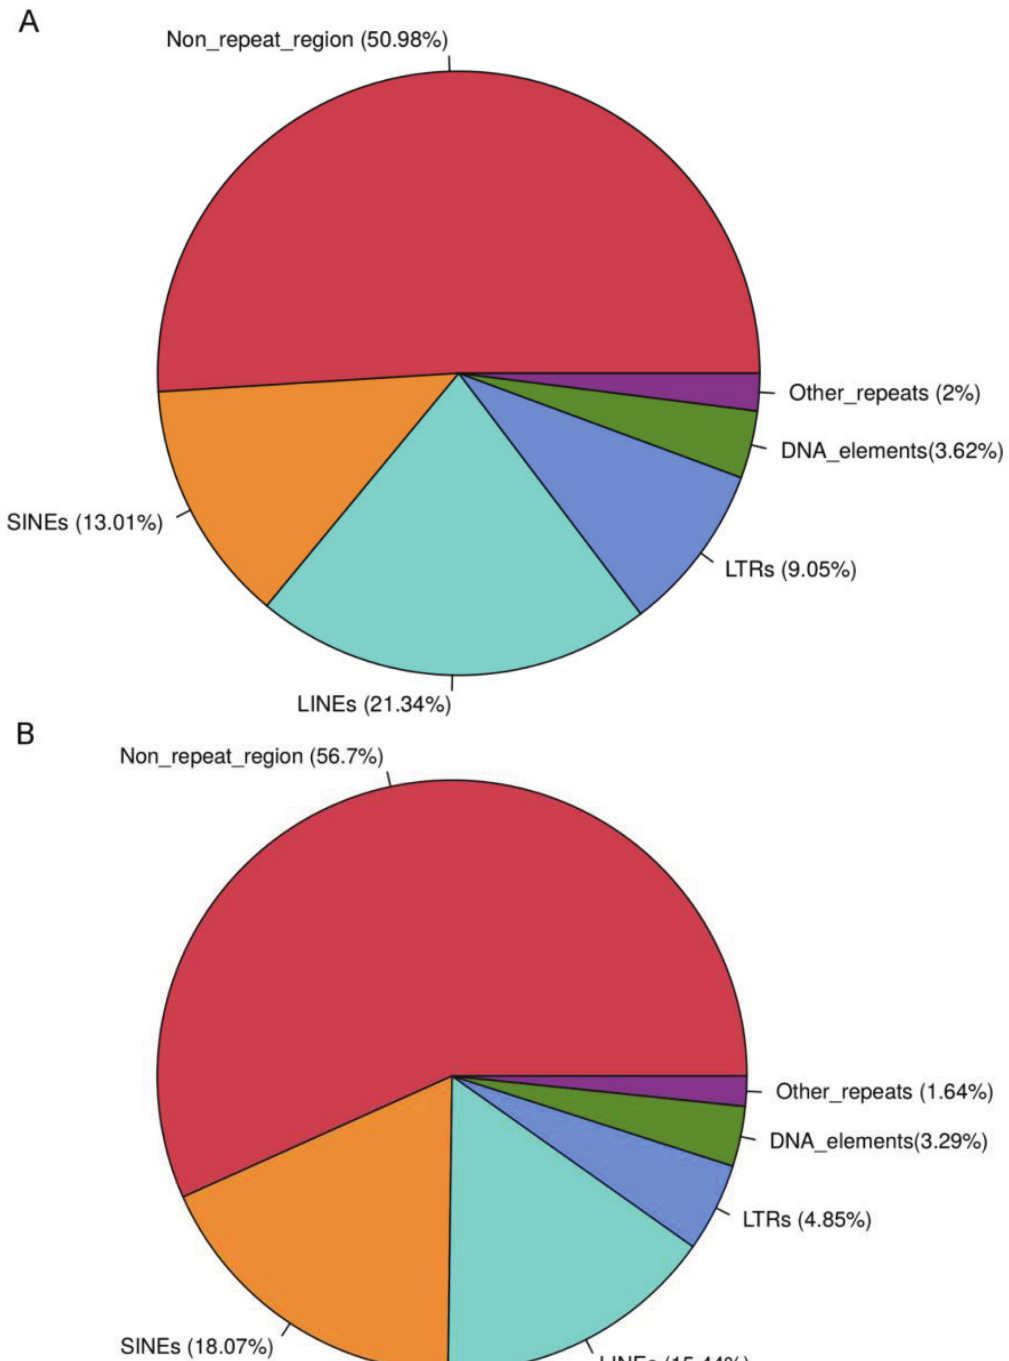
Figure 1. Repeat elements distribution in the human genome ( A ) and T1D genes ( B ). The figure shows the percentage sequence covered by different classes of interspersed repeat